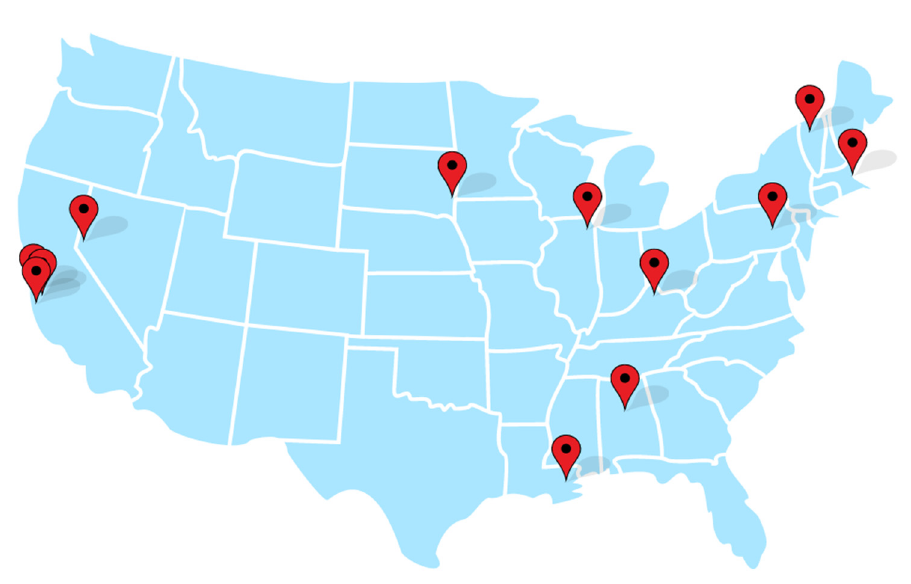
Figure 1. Locations of 12 screening programs. Table 2. Genomic Screening Programs in 4 Categories.